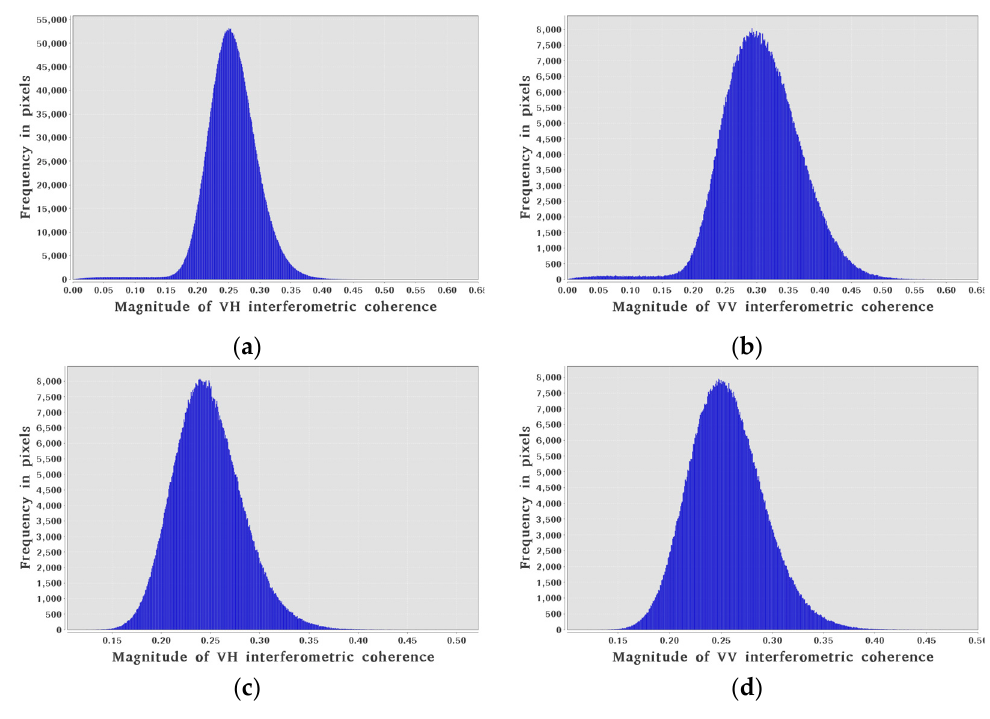
Figure 8. Interferometric coherence histogram for Sentinel-1 image pair on 6 and 18 February 2015 for: ( a ) VH polarization over the high coherence study area; ( b ) VV polarization over the high coherence study area; ( c ) VH polarization over the low coherence area; and ( d ) VV polarization over the low coherence area.